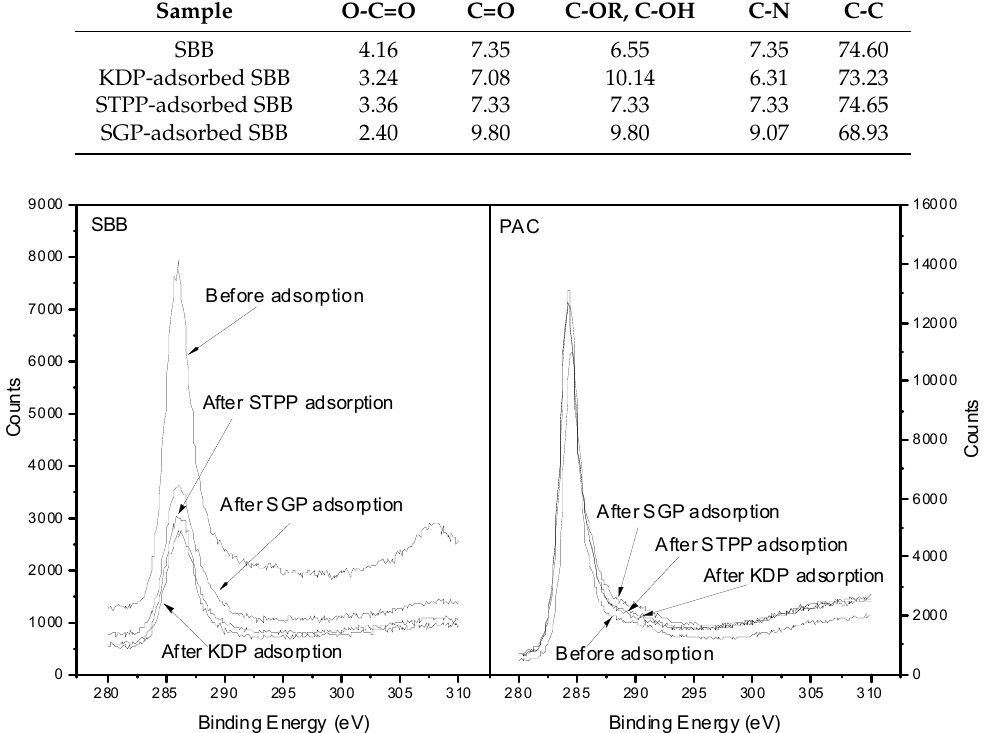
Figure 5. C1s XPS fitting curves of SBB before and after phosphate adsorptions. ( a ) C1s XPS fitting curves of SBB; ( b ) C1s XPS fitting curves of KDP-adsorbed SBB; ( c ) C1s XPS fitting curves of STPP- adsorbed SBB; ( d ) C1s XPS fitting curves of SGP-adsorbed SBB. 3.4.2. Adsorption Properties of Phosphates on SBB Characterized by XPS Analysis of Fe Element Tests were conducted to further understand the adsorption reaction of phosphates with the main content Fe on SBB surface. Fe (2p 3/2 ) XPS fitting curves of SBB before and after phosphate adsorptions are shown in Figure 6. Fe (2p 3/2 ) spectra peak was fitted using three and four multiplet peaks for Fe(II) and Fe(III) species respectively [27]. The multiple peaks of the major Fe(II) peak are at 708.3, 709.2 and 710.3 eV; and the peaks of Fe(III) are at 709.8, 711.0, 712.0, 713.0 eV. In addition, Fe 2+ and Fe 3+ satellite peaks are at about 715.0 and 718.0 eV. To fill the rest of the envelope, a peak reporting to surface structure with higher binding energy than the multiple peaks is added [27]. Relative contents